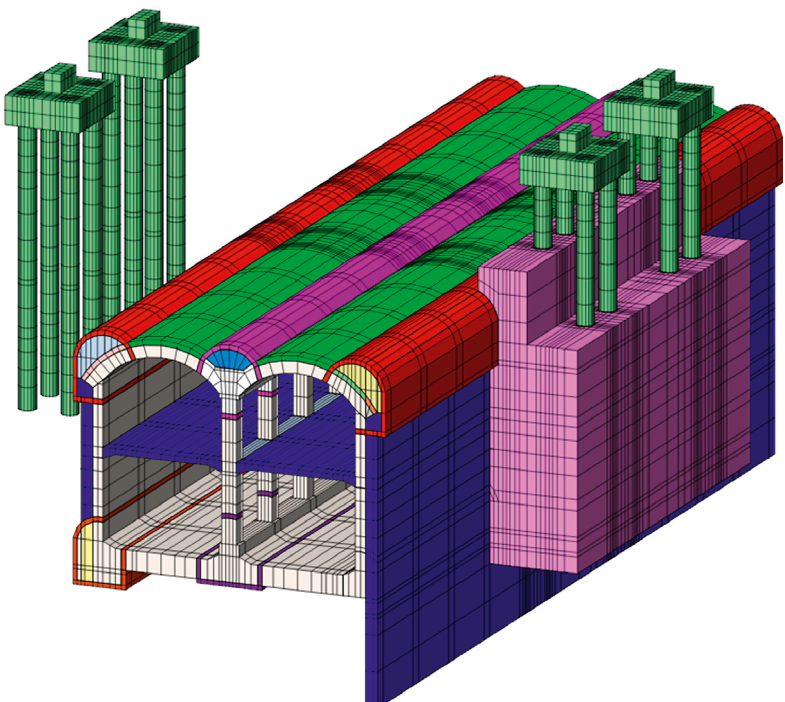
Figure 8: Numerical model.